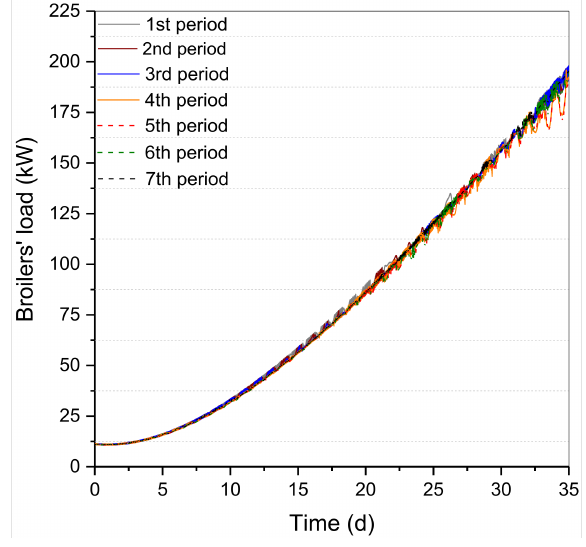
Figure 3. Broilers’ thermal loads increase during each